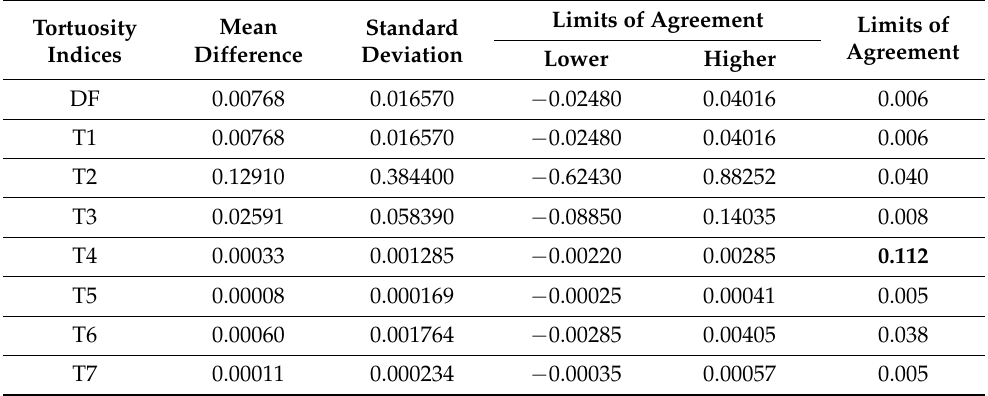
Table 5. Mean and standard deviation of individual differences. Limits of agreement and p -value of the paired t -test for the tortuosity indices. p -value > 0.05 appeared